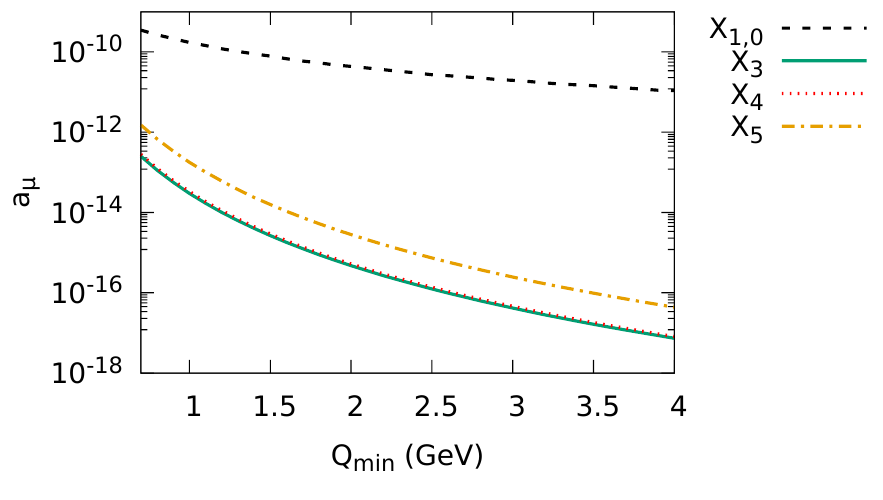
Figure 9 . Numerical contributions from the X 3 table 1. The massless quark loop is shown for comparison.